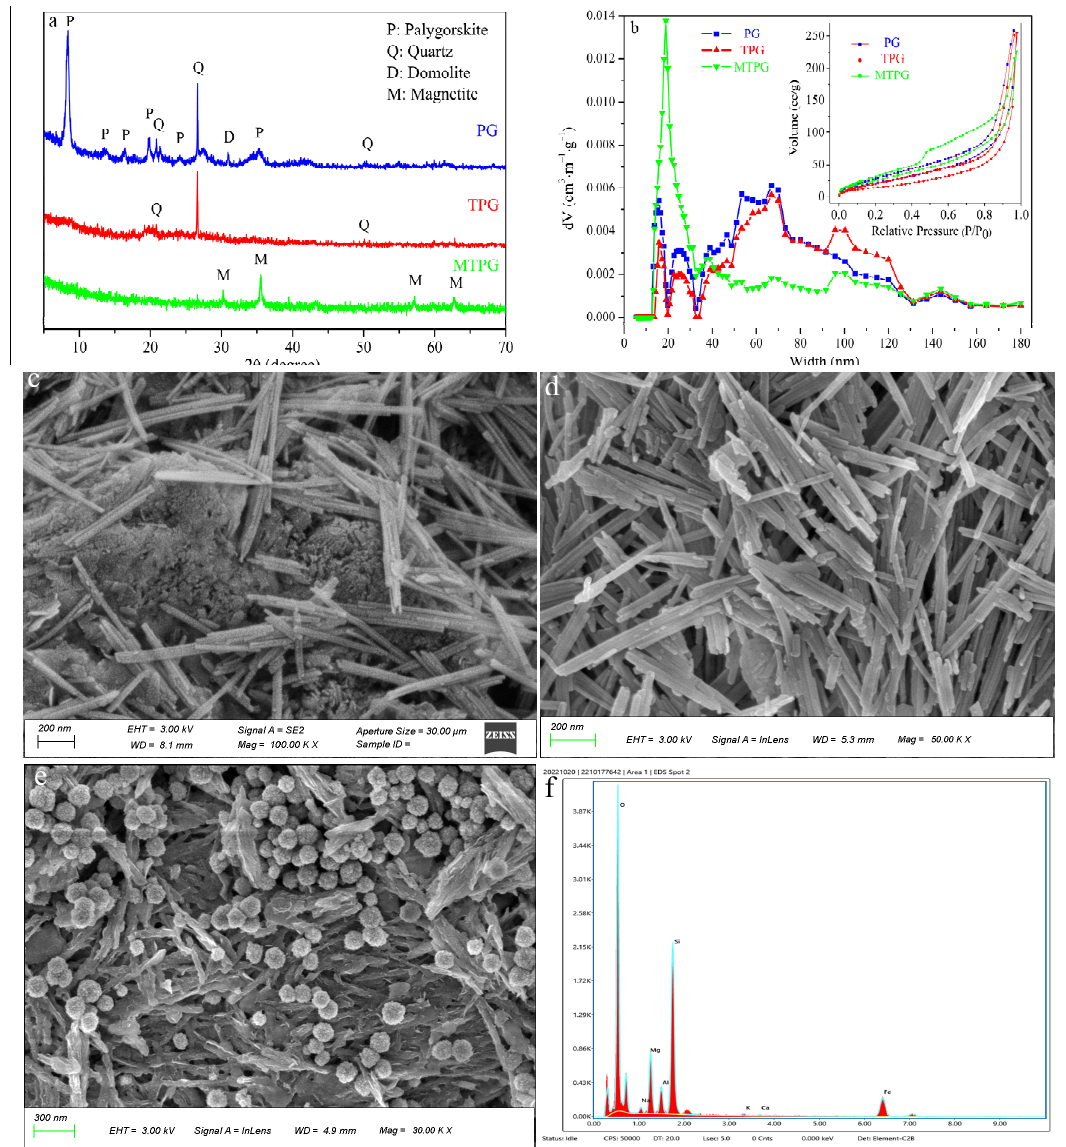
Figure 1. Characterization of mineral materials. ( a ) XRD patterns, ( b ) Pore size distributions and N 2 adsorption-desorption isotherms, ( c ) SEM of PG, ( d ) SEM of TPG, ( e ) SEM of MTPG, ( f ) EDS spectrum of MTPG.